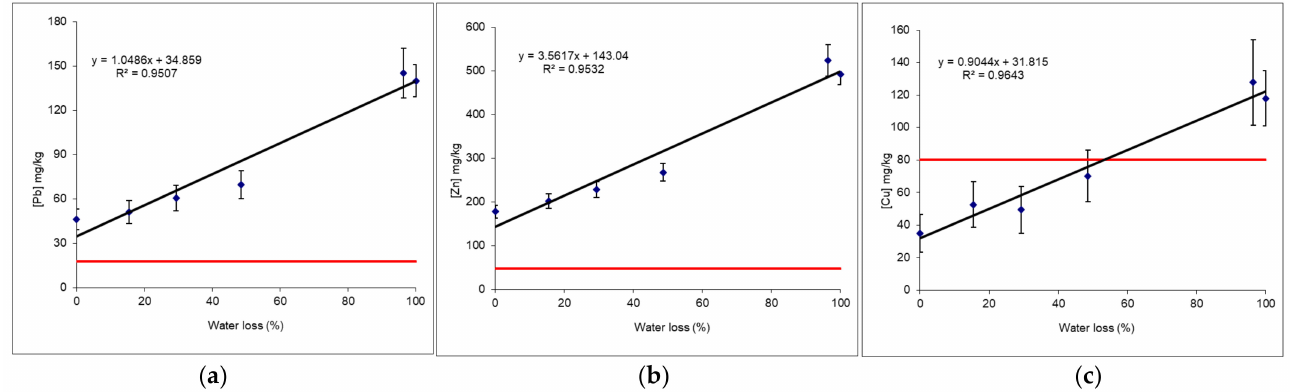
Figure 16. ( a ) Pb, ( b ) Zn and ( c ) Cu measurements by pXRF (XLt999KWY model) on wet and dried samples, the red line represents the detection limit of the element (modified from